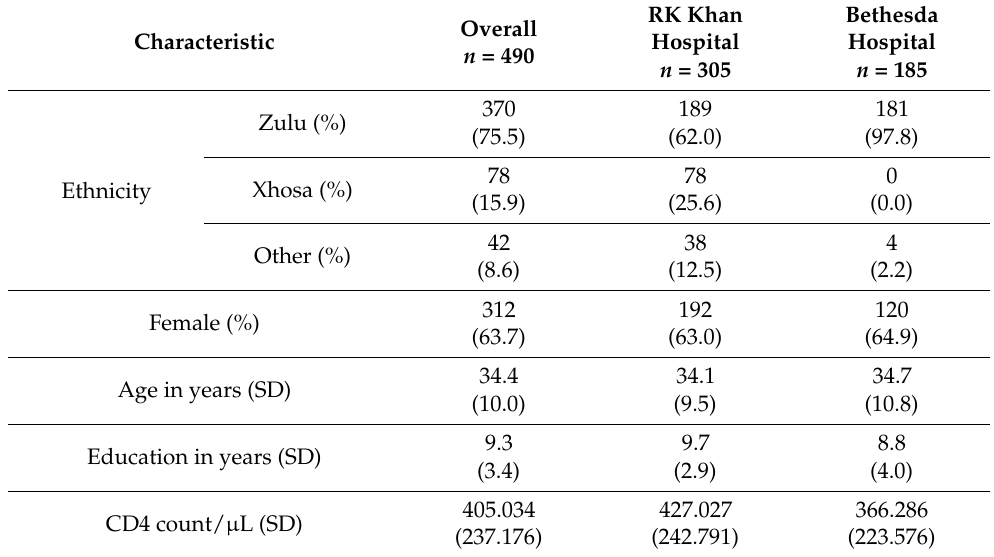
Table 1. Baseline characteristics of the study